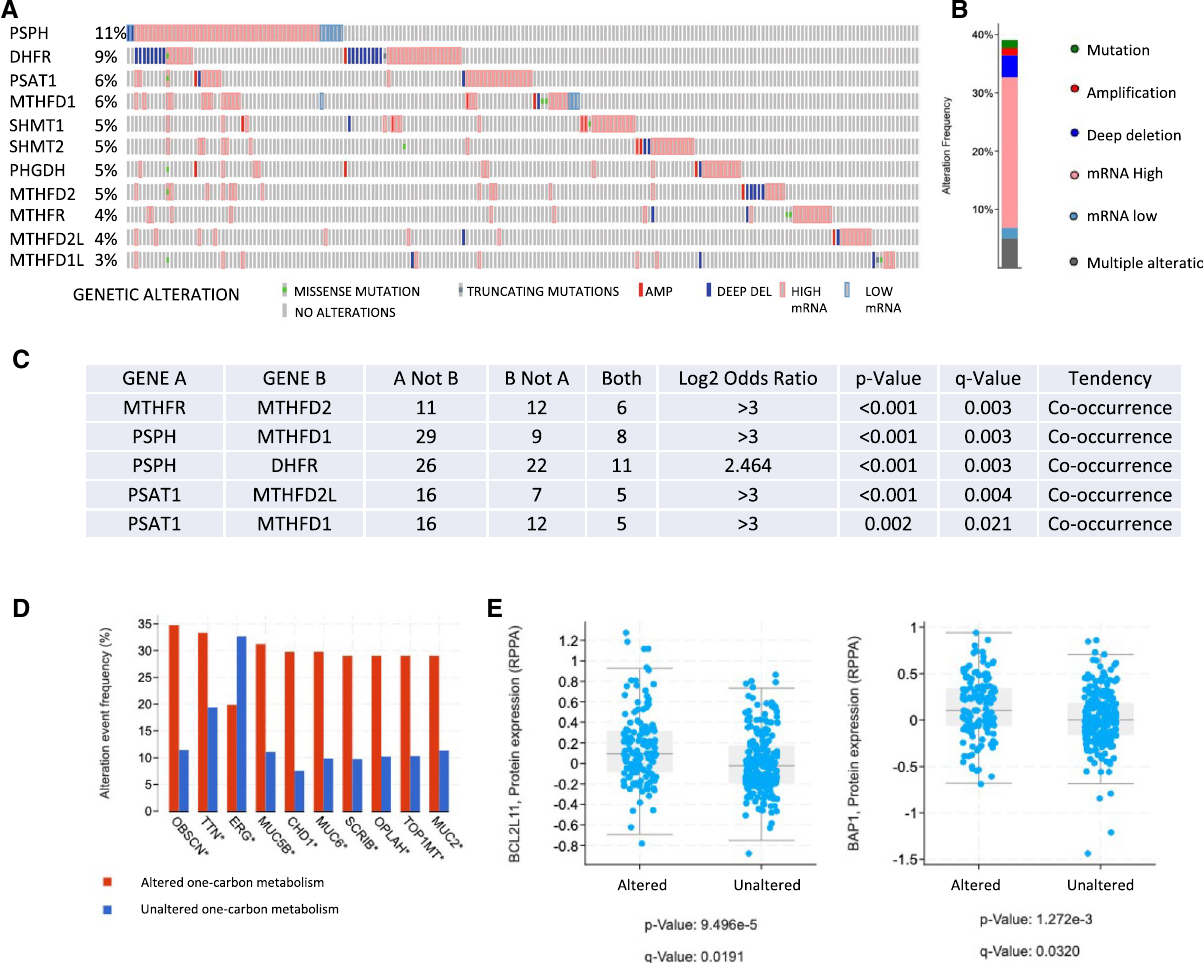
Fig. 2 One-carbon metabolism enzymes in prostate cancer overview. A OncoPrint profiling of genetic or expression alteration in genes involved in the one-carbon metabolism in a cohort of 498 patients from TCGA (AMP, amplification, DEL, deletion); B cumulative alteration frequency of the one-carbon enzymes analysed; C co-occurrence analysis of the alterations of transcription the one-carbon enzymes genes, p-values are derived from one-sided Fisher Exact Test, q-values are derived from Benjamini–Hochberg FDR correction procedure; D genomic alteration frequency of known prostate cancer driver genes in one-carbon metabolism genes altered group vs control; E log2 scale protein expression of BCL2L11 and BAP1 in one-carbon metabolism genes altered group vs control, p-values are calculated from Student’s T-test, q-values are calculated from Benjamini–Hochberg